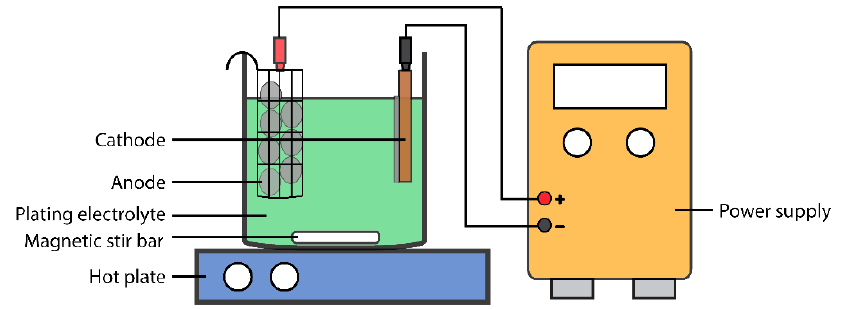
Figure 2. Schematic diagram of a lab-scale electroplating setup.